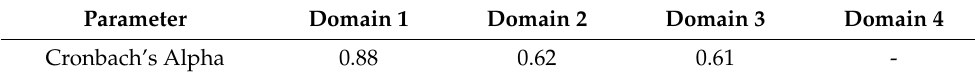
Table 4. Cronbach’s alpha values in the assessment of the reliability of domains.